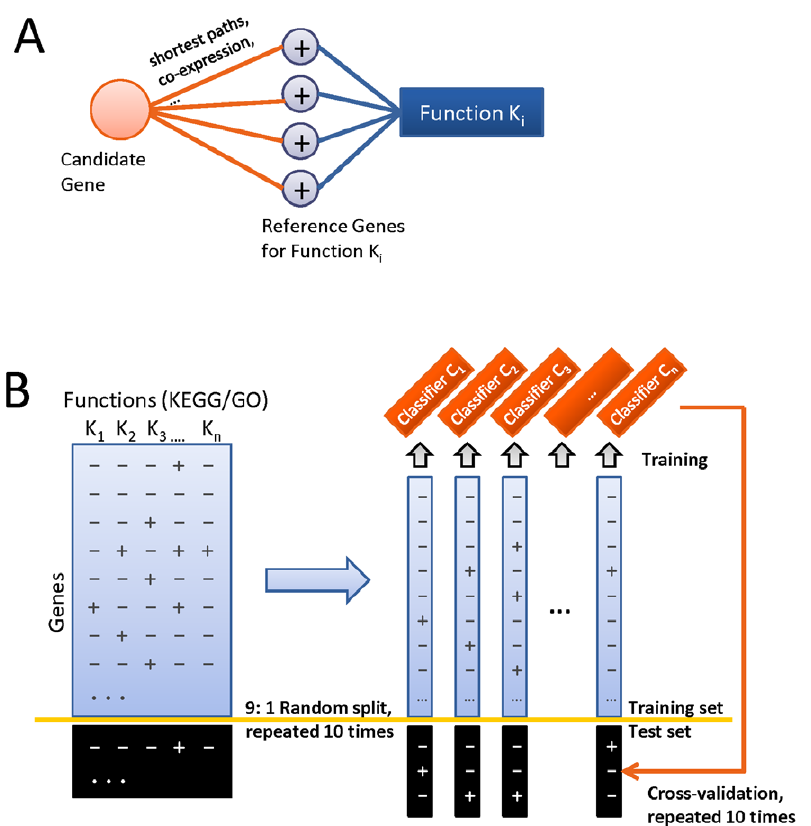
Figure 1. Overview of the Function-Specific Classifier model. A . To train the model, features describing relationships between each given candidate gene and reference genes for a given function K i were derived from large-scale biological datasets. B . Results were evaluated by 10-fold cross-validation.